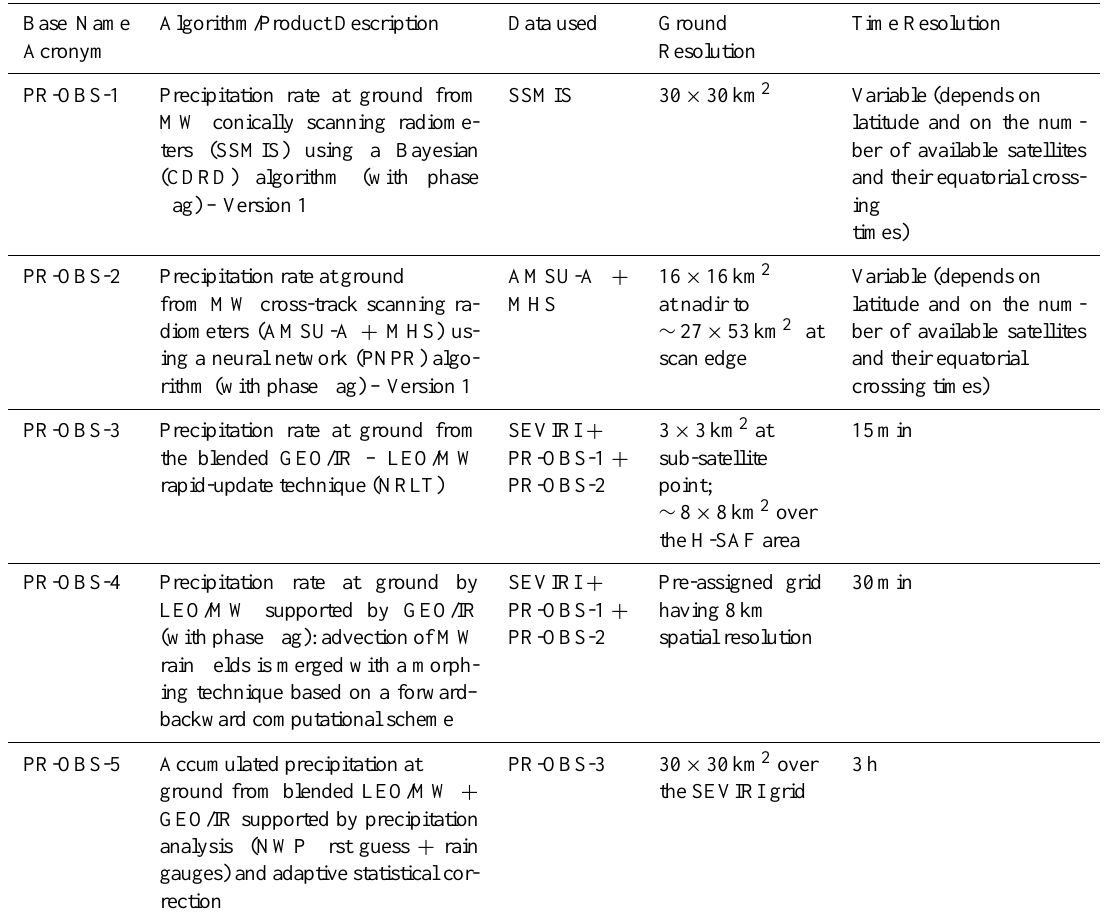
Table 1. H-SAF precipitation algorithms/products that have been validated by the